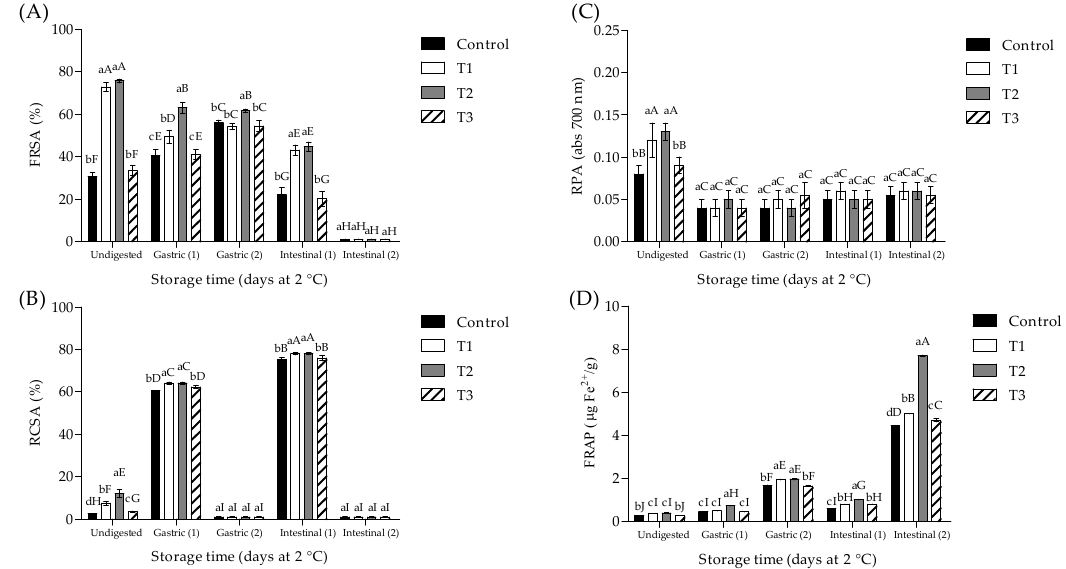
Figure 3. FRSA, RCSA, RPA, and FRAP values (( A – D ), respectively) of cooked pork patties before and after ivGD. T1, POP at 2%; T2, POP at 5%; T3, BHT at 0.02%. Lowercase letters indicate differences between treatments on each digestion step; capital letters indicate differences in each treatment through ivGD ( p < 0.05).